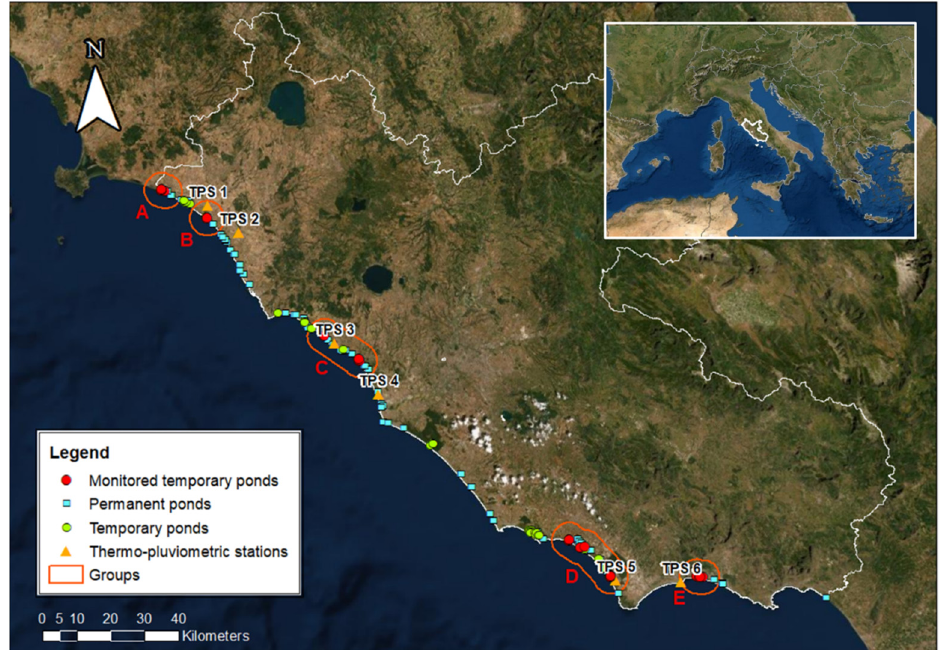
Figure 1. Permanent (light blue squares) and temporary (green and red circles) coastal wetlands within the study area. The 21 selected and monitored Mediterranean temporary ponds are indicated with red circles and divided into five groups according to proximity amongst pools and land use context: A, pastures; B, agricultural with grasses; C, reserves; D, urban; E, mixed agricultural and